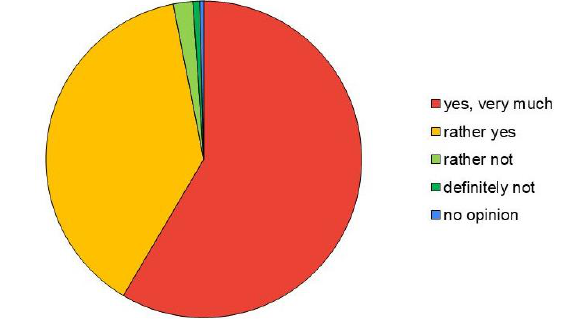
Fig. 2. Distribution of answers to the question "Do you feel connected with the place where you work?"